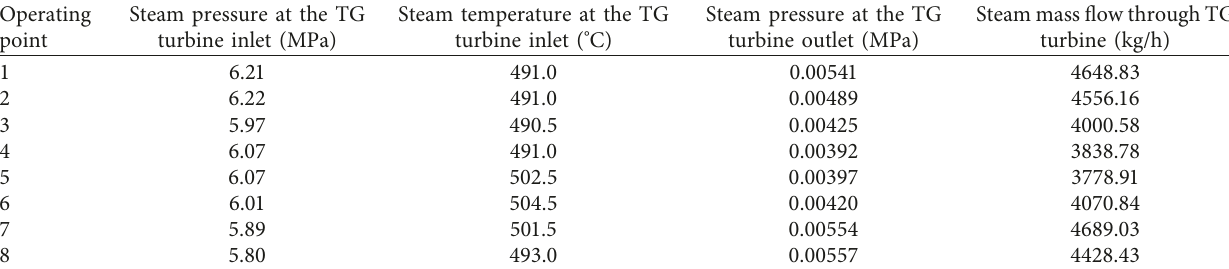
Table 2: Measurement results for TG steam turbine in various operation regimes.